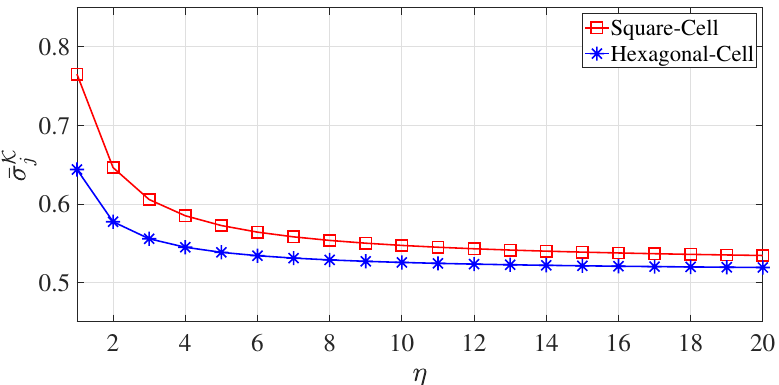
Figure 4. The convergence trends of ¯ σ K